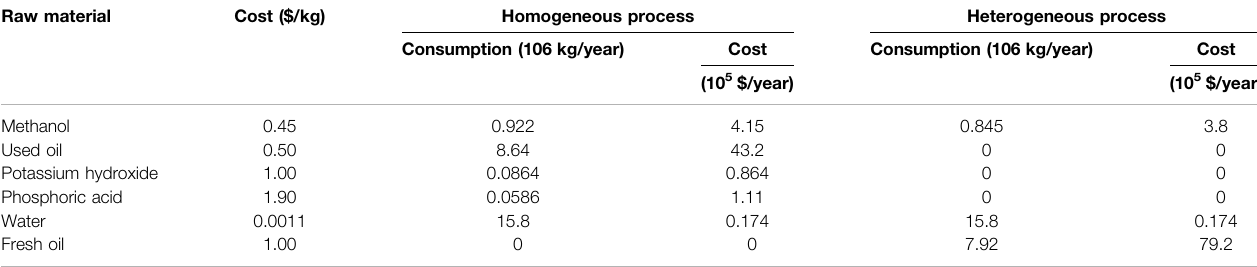
TABLE 3 | Market costs, annual consumptions, and total cost of raw materials for the homogeneous and heterogeneous processes. Raw